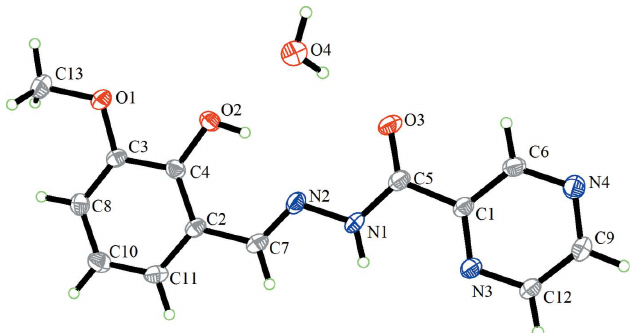
Figure 1 The molecular structure of the title compound showing displacement ellipsoids drawn at the 30% probability